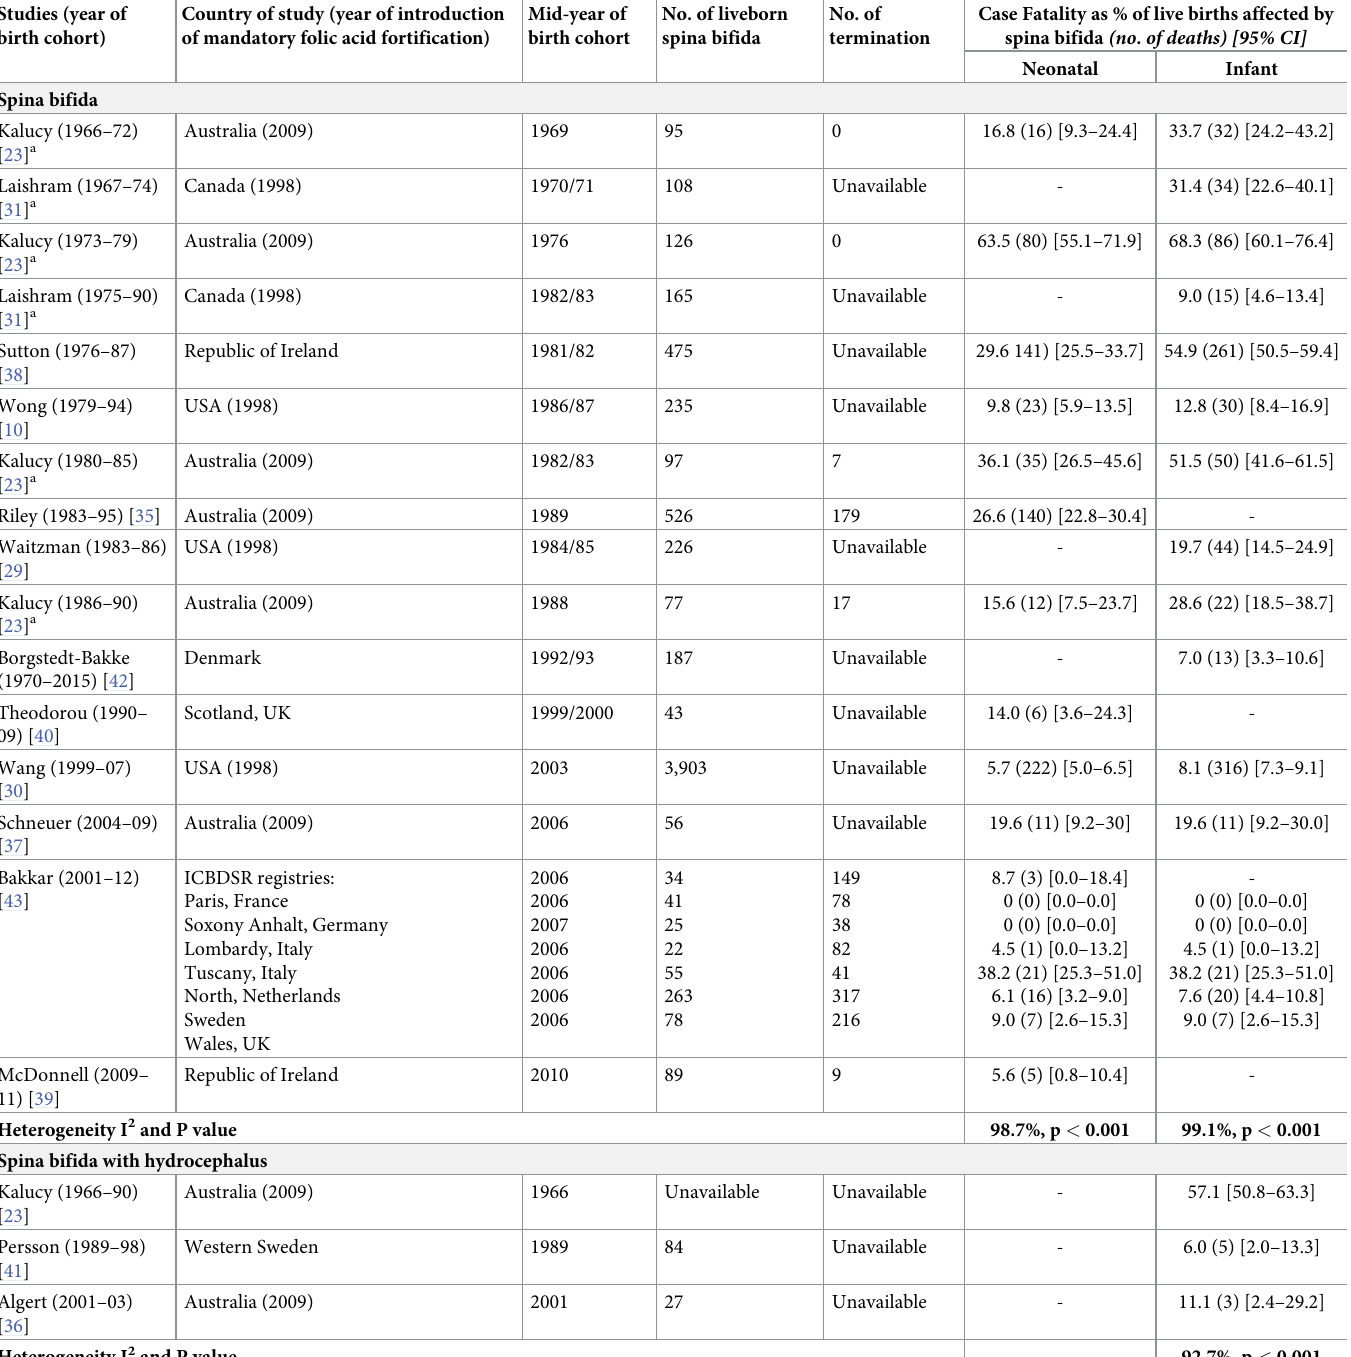
Table 3. Neonatal and infant case fatality from spina